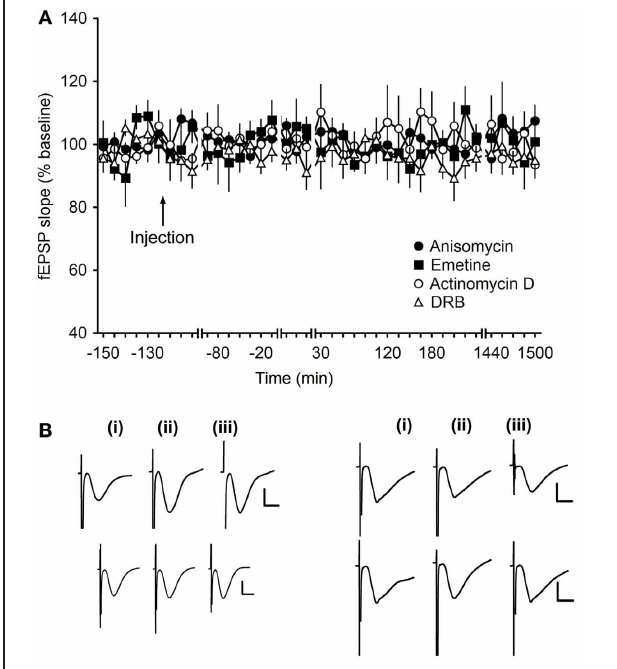
FIGURE 6 | Application of translational- and transcriptional-Inhibitors do not alter basal synaptic transmission. (A) After injection of anisomycin (4.8 μ g), emetine (240 μ g), actinomycin D (72 μ g) or DRB (20nM), fEPSPs recorded during test-pulse stimulation showed stable responses for over 24h. Line breaks indicate change in time scale. (B) Analog traces recorded during test-pulse experiments show fEPSP responses 5min pre-injection (left traces), 5min post-injection (middle traces) and 24h after injection (right traces), in the anisomycin experiment (upper left), in the emetine experiment (lower left), in the actinomycin D experiment (upper right), and in the DRB experiment (lower right). Vertical scale bar: 2mV, horizontal scale bar: